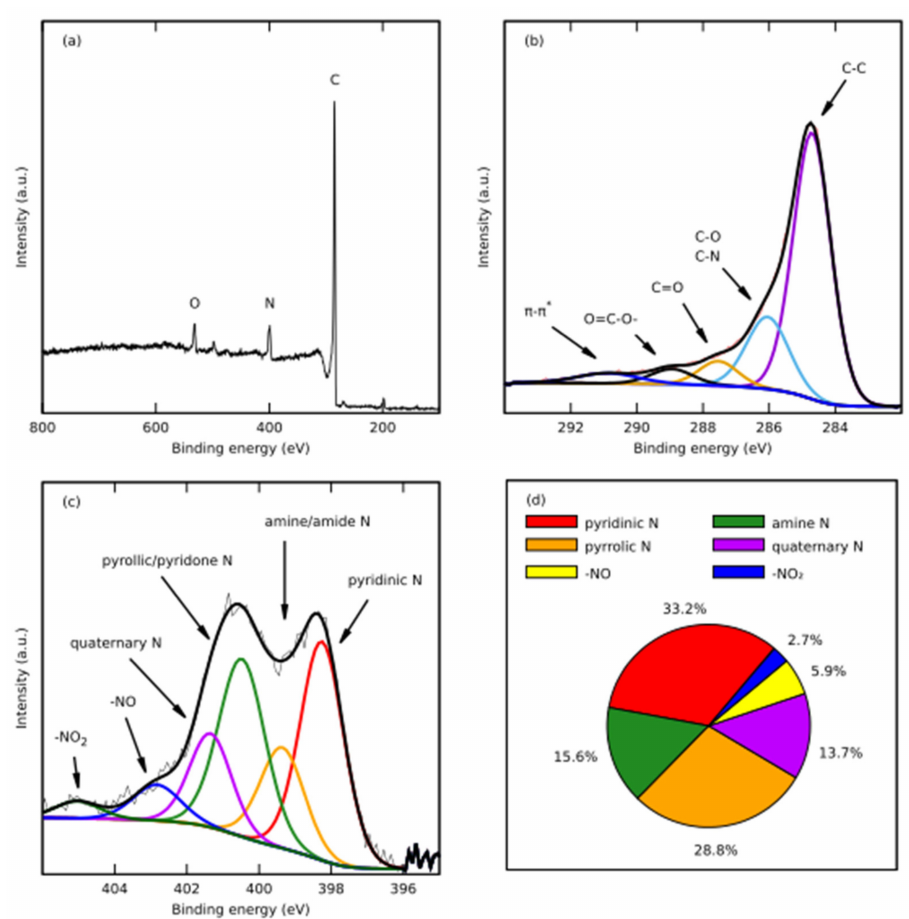
Figure 5. ( a ) XPS spectra of CH_K carbons; high-resolution ( b ) C 1s and ( c ) N 1s of N-doped carbon; ( d ) atomic percentage of the nitrogen functional groups in